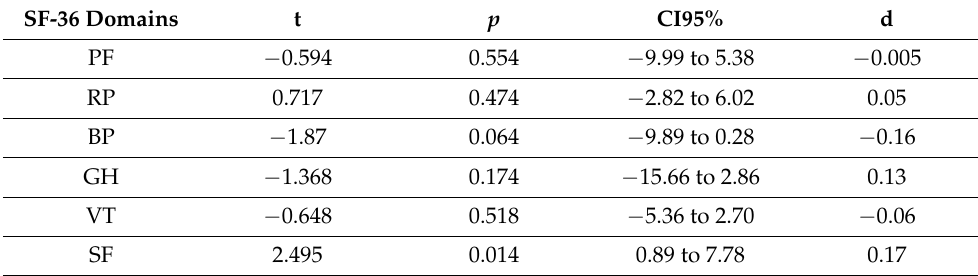
Table 4. Analysis of the evolution between 3 and 12 months of the domains of the SF-36